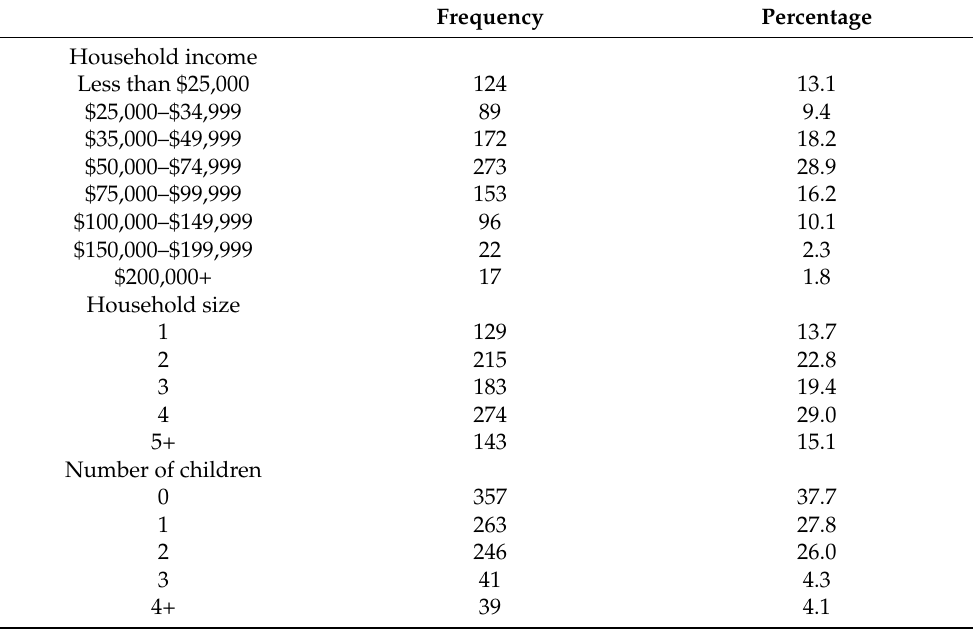
Table 2. Household characteristics of US adults who completed the COVID-19 and Food Waste Questionnaire ( N =